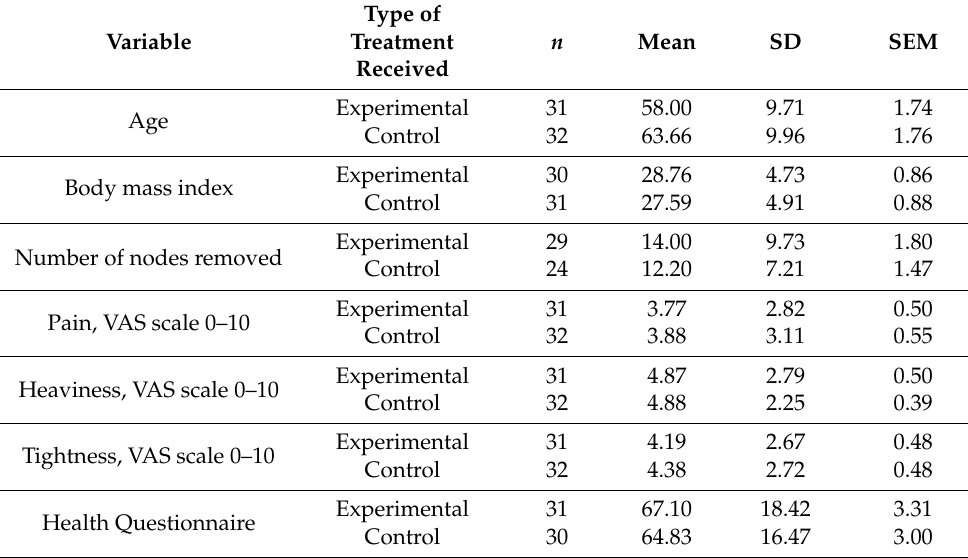
Table 1. Analysis of the baseline comparability of both